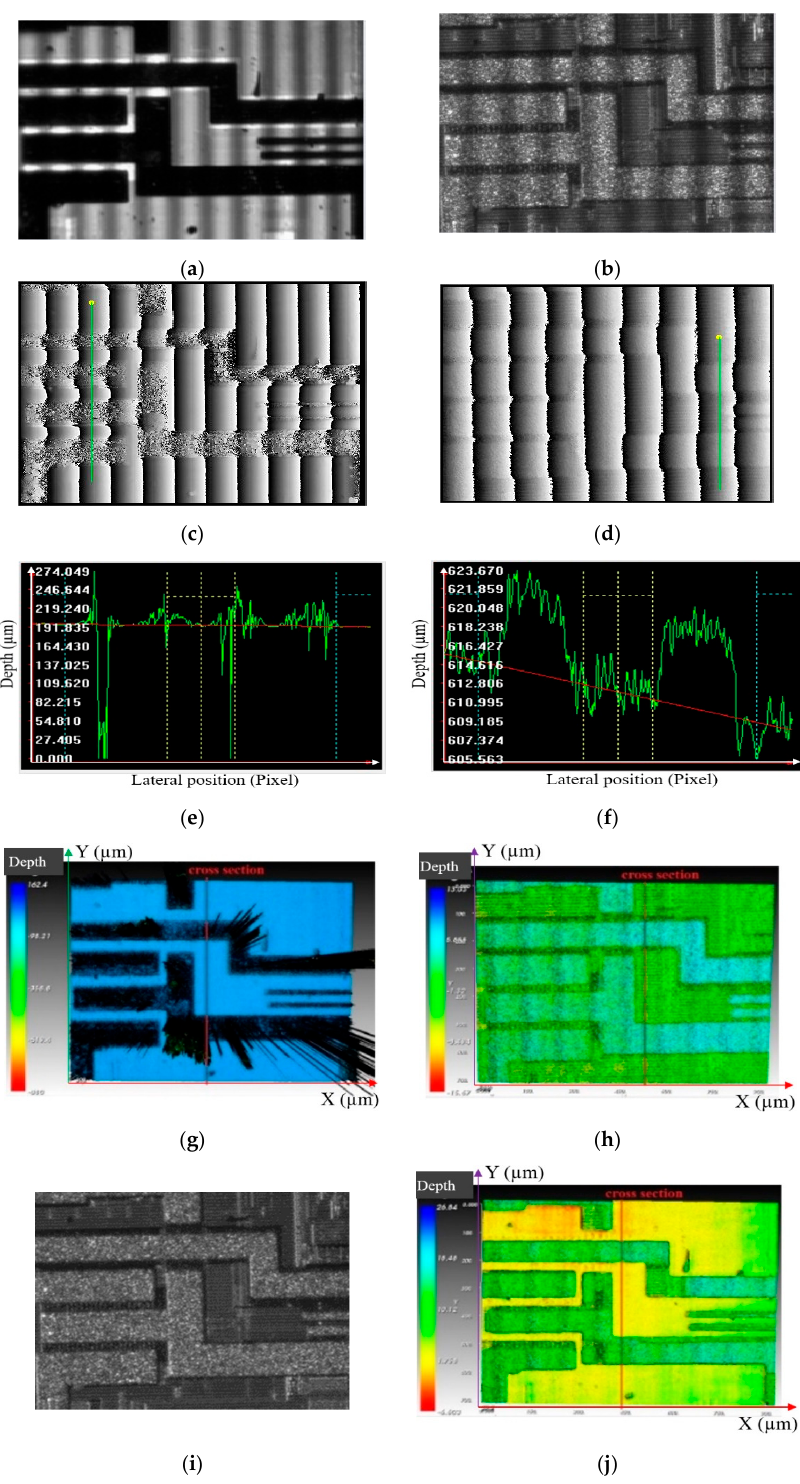
Figure 14. Measurement results of industrial IC chip: ( a ) image captured by camera receiving specular light; ( b ) image captured by vertical camera; ( c ) wrapped phase map of tilted camera; ( d ) wrapped phase map of vertical camera; ( e ) cross-section on wrapped phase map of tilted camera; ( f ) cross-section on wrapped phase map of vertical camera; ( g ) 3-D shape of IC chip measured by tilted camera; ( h ) 3-D shape of IC chip measured by vertical camera; ( i ) measured ROI of industrial IC chip; and, ( j ) 3-D shape of measured ROI in ( i